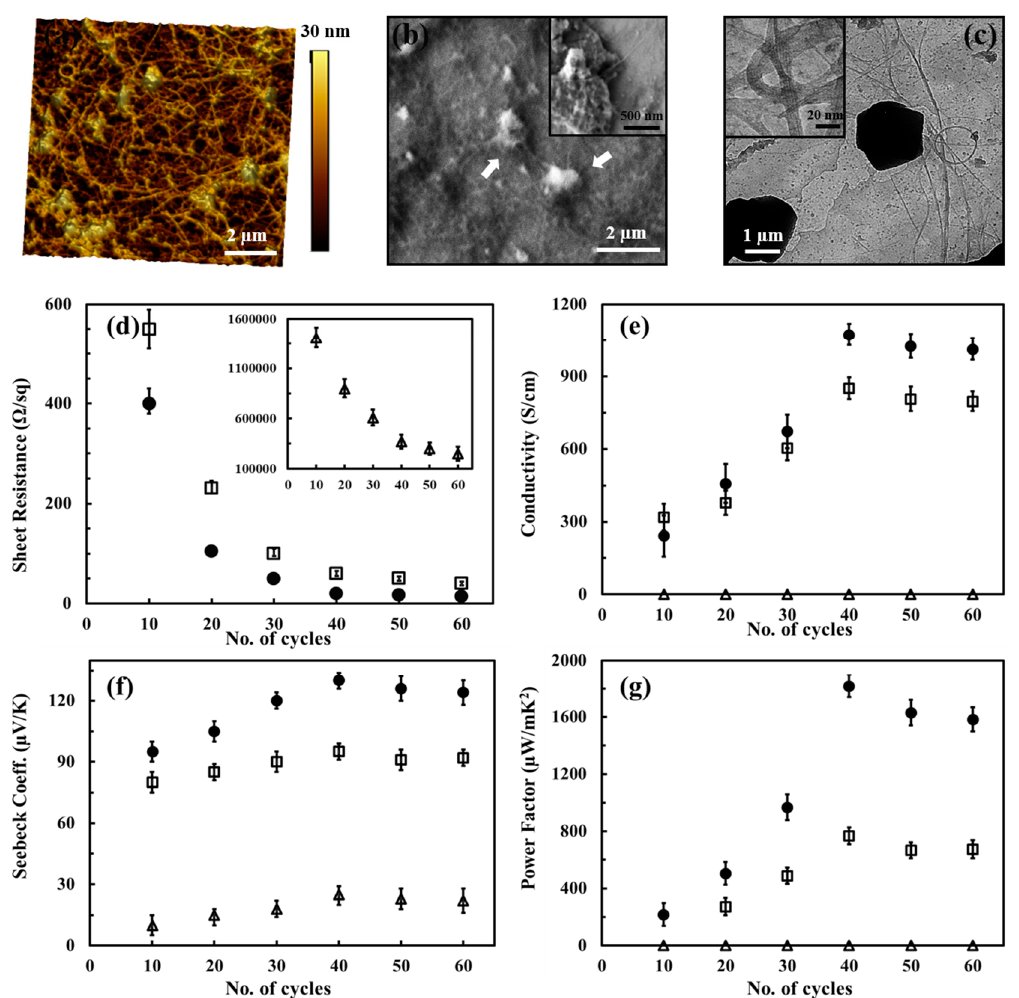
Figure 9. ( a ) The AFM 3D height image, ( b ) SEM, and ( c ) TEM images of the thin films. The insets in the SEM and TEM images show higher resolution graphene platelets and DWNT, respectively. The arrows indicate graphene in the film. ( d ) Sheet resistance, ( e ) electrical conductivity, ( f ) seebeck coefficient, and ( g ) power factor of PANi/graphene (open triangles), PANi/DWNT (open squares), and PANi/graphene/PANi/DWNT (filled circles) as a function of bilayers or quadlayers (i.e., cycles) deposited on a poly(ethylene terephthalate) (PET) substrate. Reprinted with permission from [76].